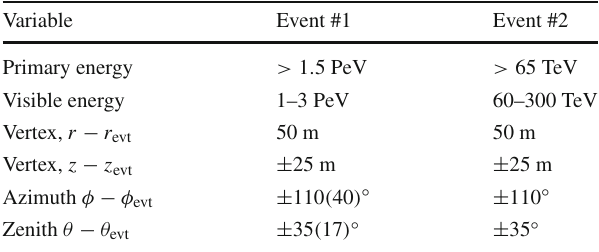
Table3 Parameterspaceforresimulatedevents.Theuppervalue ofthe primary energy depends on the interaction type, reflecting the spread of visible energy losses typical of that interaction. The visible energy is the energy transformed into light, it equals the total energy deposited in the detector for electromagnetic showers and is lower for hadronic showers and events with final-state muons or neutrinos. r − r evt is the two-dimensional distance in the x , y -plane. The values in